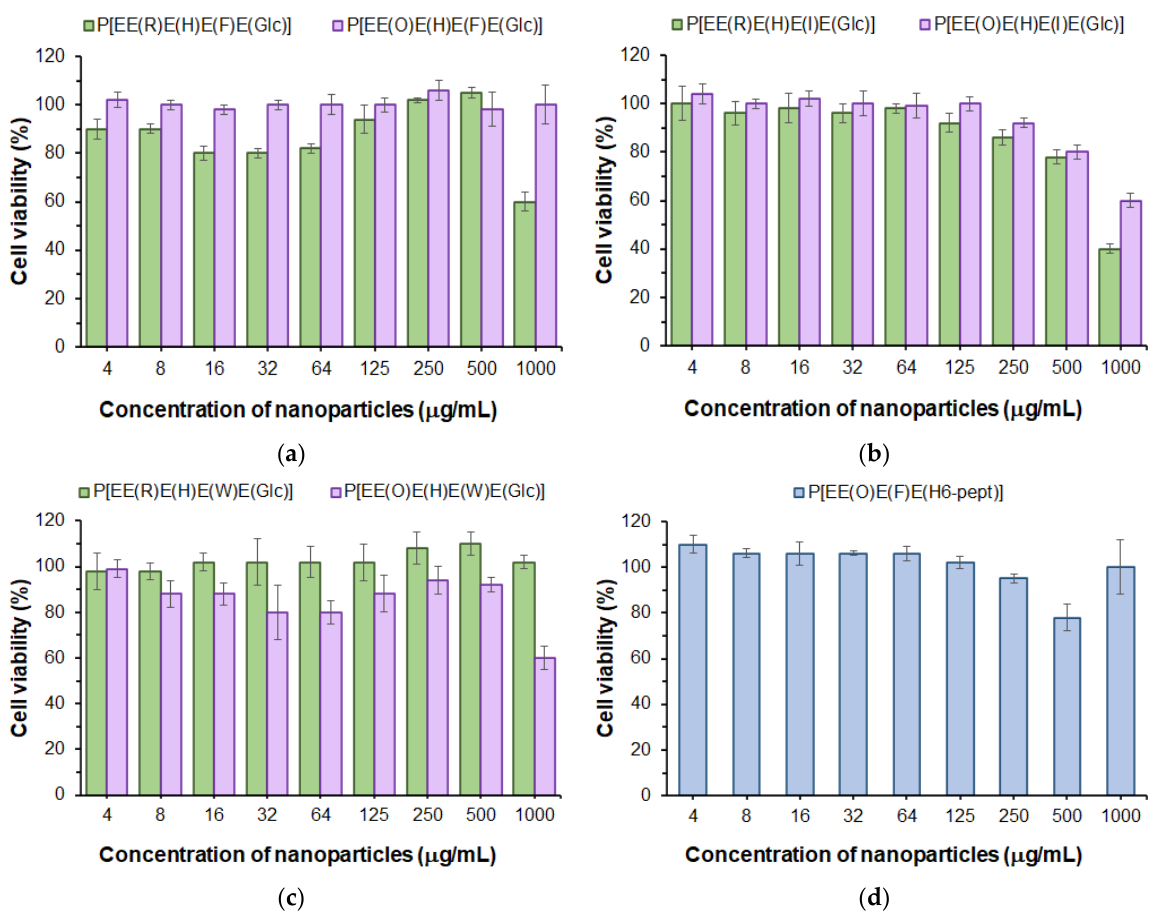
Figure 7. Viability of BEAS ‐ 2B cells in the presence of nanoparticles based on Phe ‐ ( a ), Ile ‐ ( b ) and Trp ‐ containing glycopolypeptides ( c ) as well as nanoparticles self ‐ assembled from a polypeptide modified with H 6 ‐ peptide ( d ) (CTB assay, 72 h).